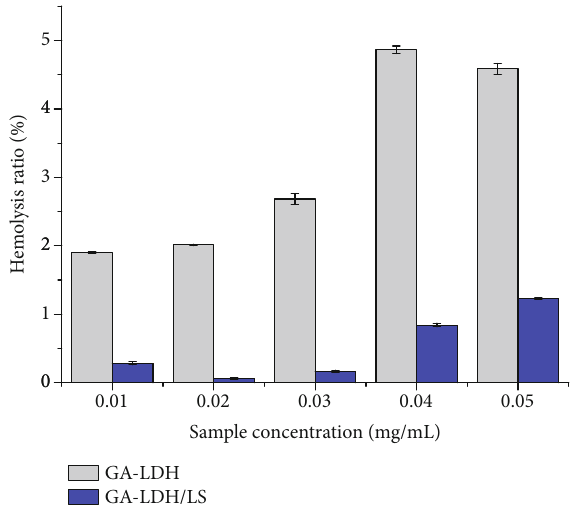
Figure 10: Hemolysis percentage of di ff erent concentration GA-LDH and GA-LDH/LS( n = 3 , x ± s